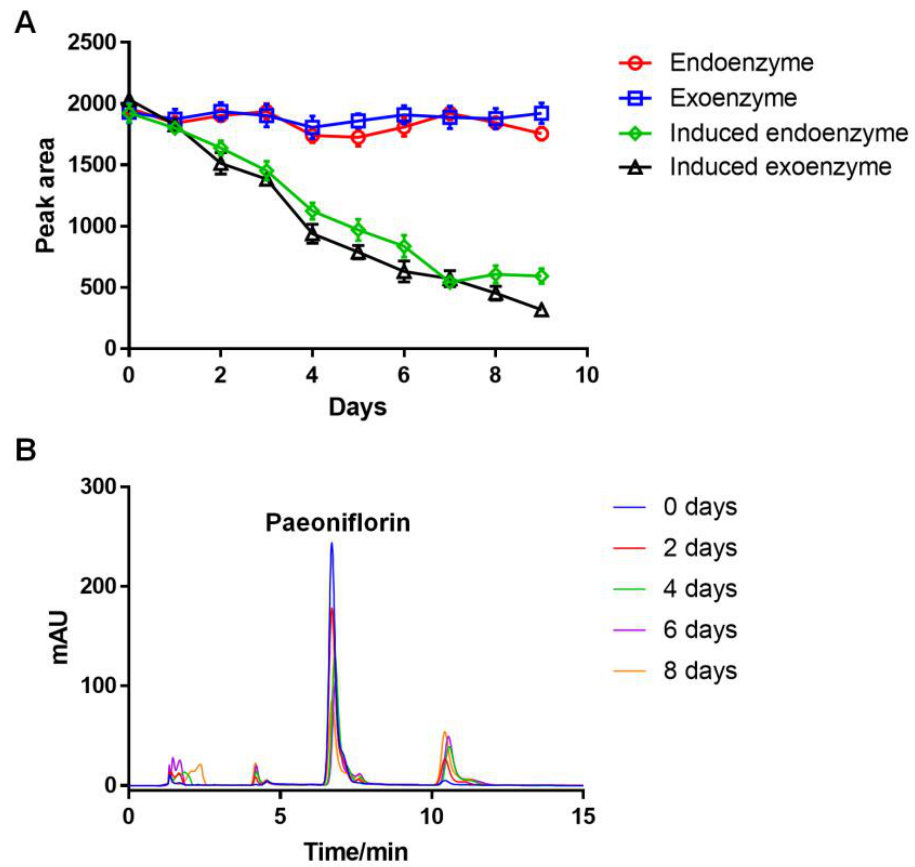
Figure 1. The conversion effects of the key enzymes. ( A ) 100 mL of the Cunninghamella blakesleeana (AS 3.970) medium was poured off and induced by adding 1.5 mL of paeoniflorin solution (1 mg/mL). The peak area of paeoniflorin was measured via HPLC. The endoenzyme was obtained from the supernatant after cell fragmentation and subsequent centrifugation, and the exoenzyme was the supernatant medium. Both the induced endoenzyme (green diamond) and exoenzyme (black triangle) by paeoniflorin had comparable conversion effects. ( B ) HPLC analysis of the conversion activity of the induced exoenzyme, obtained on an Agilent ZORBAX SB-C18 (4.6 × 250 mm, 5 µ m); column temperature, 30 ◦ C; mobile phase, H 2 O (0.2% phosphoric acid):methanol = 70:30 ( v / v ); flow rate, 1.0 mL/min; injection volume, 10 µ L; detection wavelength, 230 nm. After 8 days of reaction, the paeoniflorin was converted by the induced